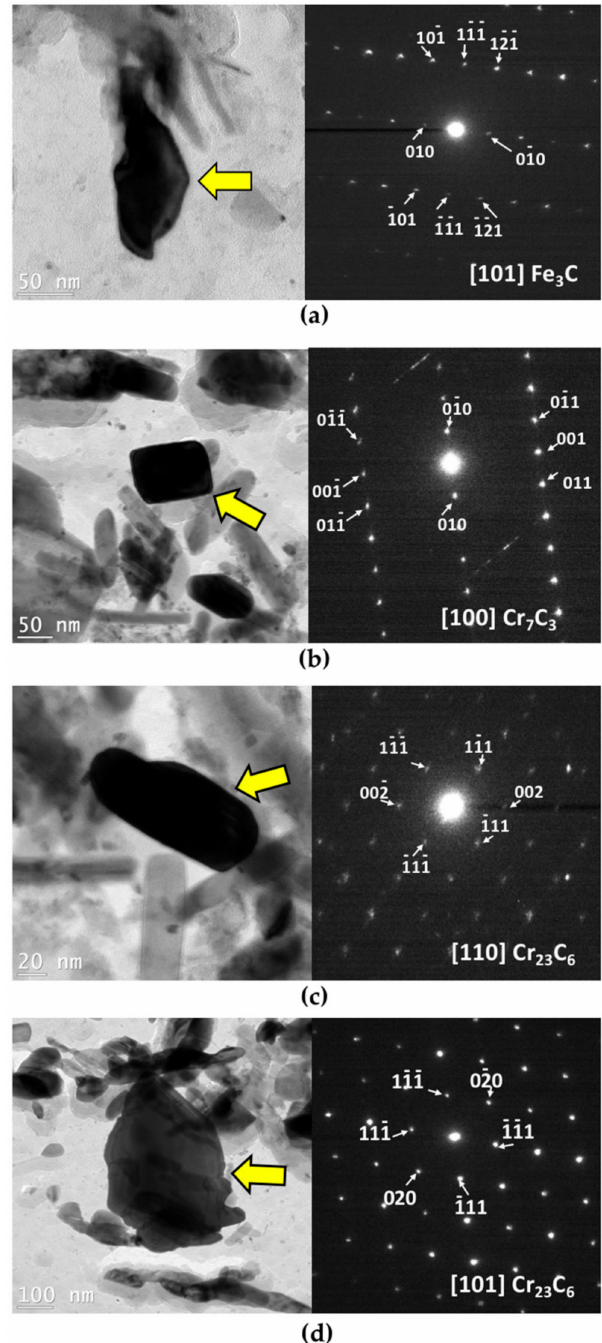
Figure 9. Bright-field TEM image and corresponding selected area electron diffraction (SAED) pattern of ( a ) Fe 3 C carbide after 1 h of tempering at 550 ◦ C; ( b ) Cr 7 C 3 carbide after 16 h of tempering at 600 ◦ C; ( c ) and ( d ) Cr 23 C 6 carbides after 16 h of tempering at 600 ◦